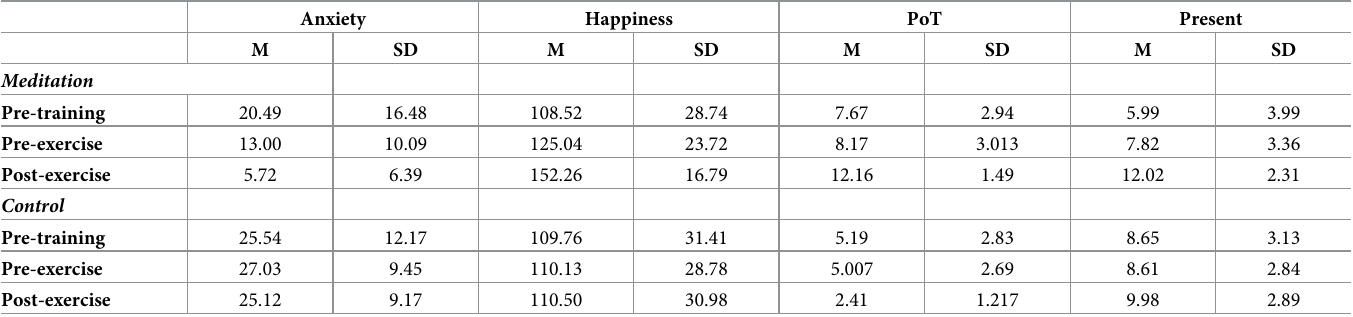
Table 1. Scores on the self-reported